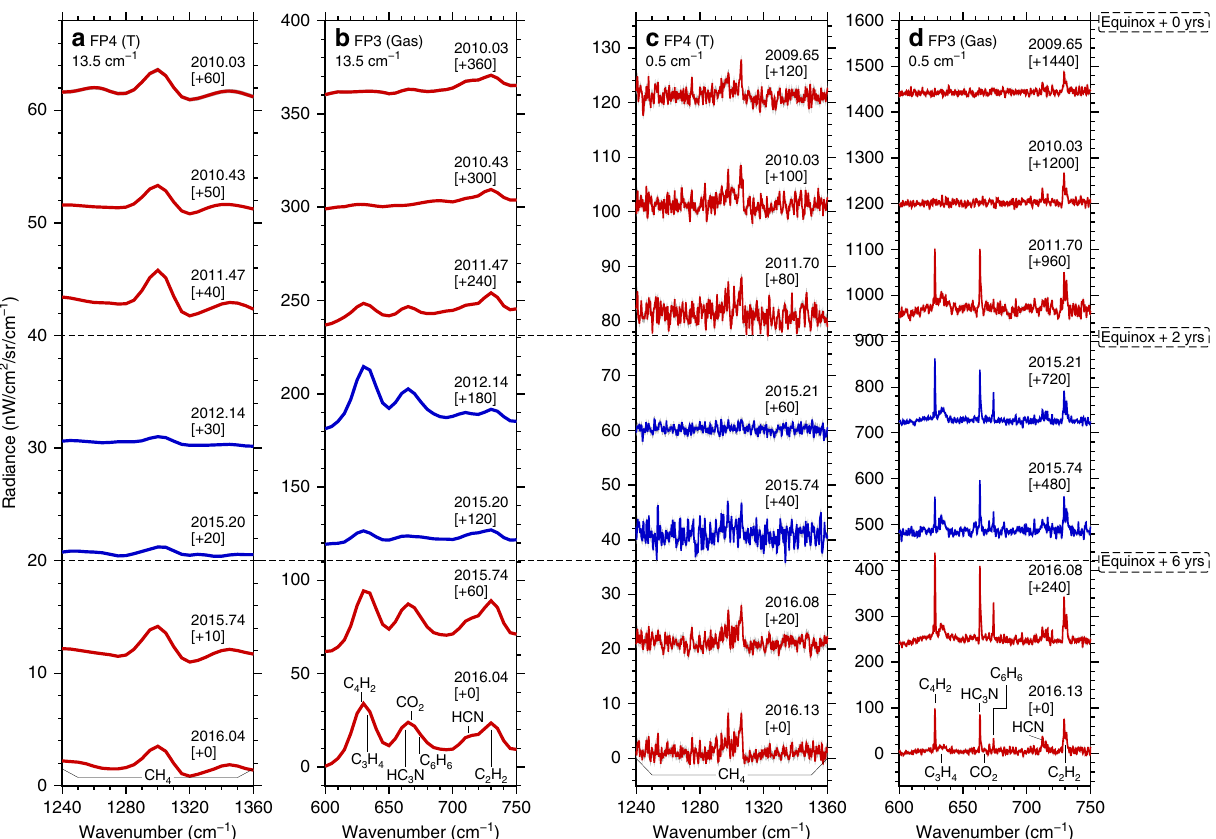
Fig. 2 Post-equinox evolution of Cassini CIRS thermal emission spectra of Titan ’ s south polar vortex from 2010 to 2016. CIRS spectra are taken in limb viewing mode and are measured at 80°S latitude and 400km altitude (mesosphere). a , b 14 cm − 1 and c , d 0.5 cm − 1 spectral resolution. a , c The ν 4 methane emission at 1300 cm − 1 is sensitive to temperature and indicates evolution from a hot mesosphere (2010 – 2011), to a cold mesosphere (2012 – 2015), and fi nally returning to a hot mesosphere in late 2015. b , d Emission from photochemically produced trace species HCN, HC 3 N, C 2 H 2 , C 3 H 4 , C 4 H 2 and C 6 H 6 is signi fi cantly increased from 2011 onwards. Spectra are offset for clarity (offset given in square brackets). Note that the temporal coverage of CIRS observations is not continuous as it depends on Cassini ’ s orbital geometry, so there is no limb coverage of the south pole in 2013 and